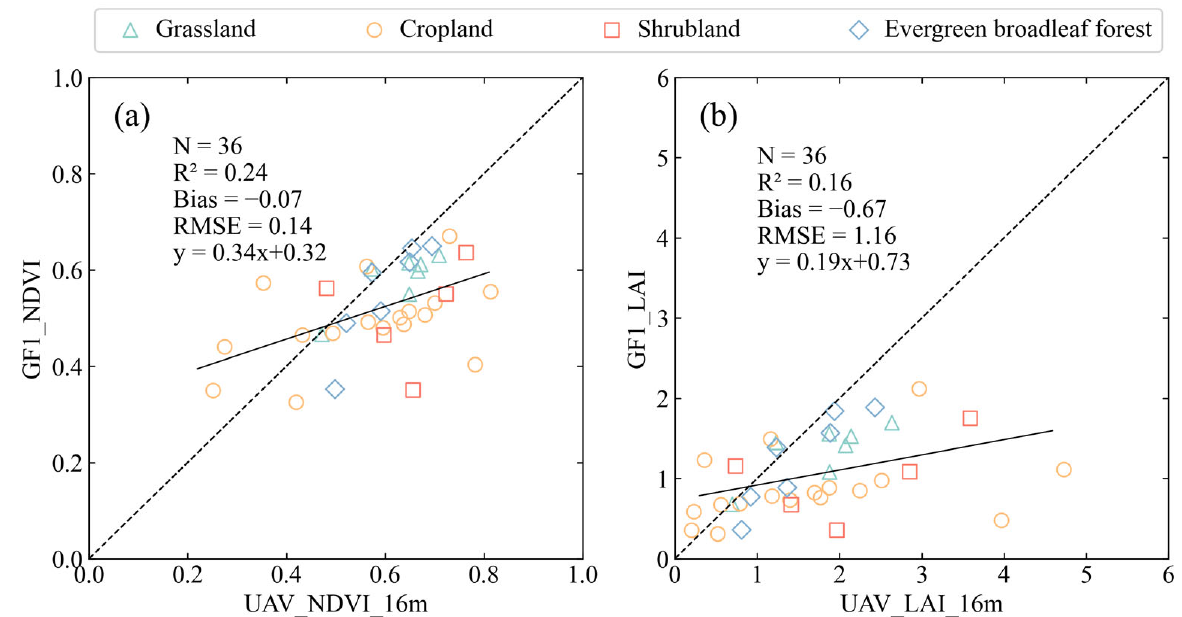
Figure 7. Differences between UAV and GF1 reflectance. ( a ) Differences between NDVI from GF-1 reflectance and from UAV reflectance. ( b ) Scatter between UAV_LAI_16m and GF1_LAI.